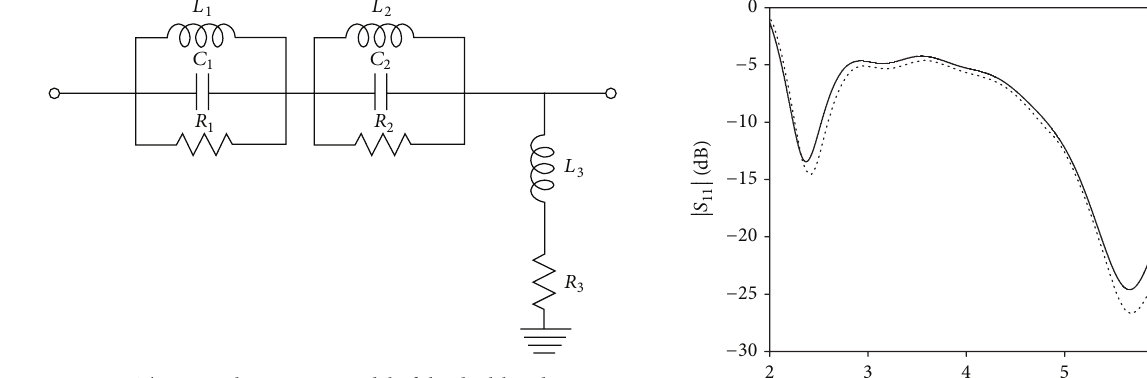
Figure 13: The equivalent circuit model of the dual-band antenna.